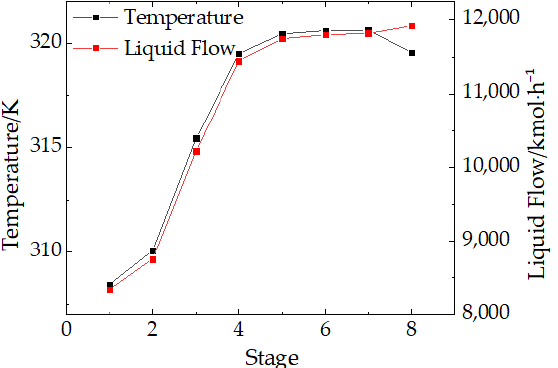
Figure 2. Temperature and liquid flowrate profiles of absorber. The red line represents the liquid flow while the black line represents the temperature.